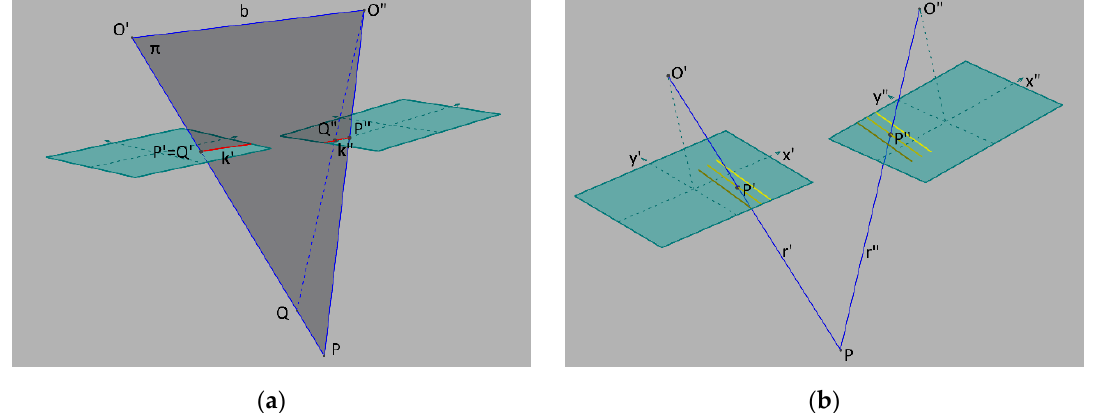
Figure 11. Three-dimensional reconstruction procedure: ( a ) calculated epipolar line in red; ( b ) the obtained key points and their resection. Symbol descriptions: O′, O″—left and right image projection centers; b—baseline, k’, k″—epipolar lines, respectively, on the left and the right image; π—epipolar plane; Q, P—points in 3D space; P′, P″, Q′, Q″—P, Q points projections on the left and the right image;